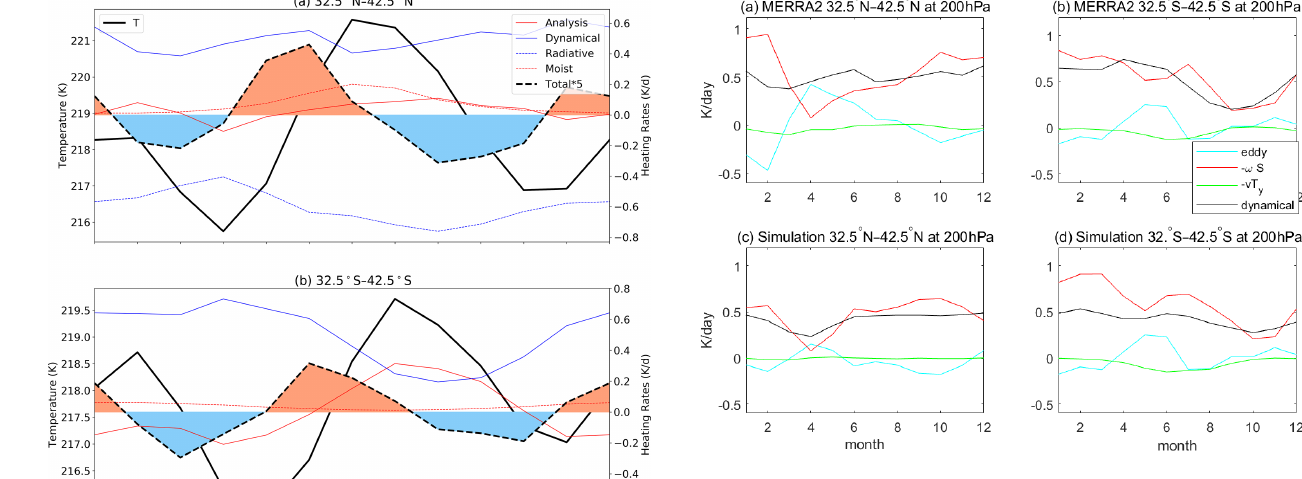
Figure 6. Annual cycle of dynamical heating rates at 200hPa aver- aged around the NHM 32.5–42.5 ◦ N (a) and the SHM 32.5–42.5 ◦ S based on MERRA2 (a–b) and control simulation (c–d) . The cyan, red, green and black lines are the eddy, heating by downwelling ( − wS), heating by the meridional component of the residual circu- lation ( − vT y ) and dynamical term,